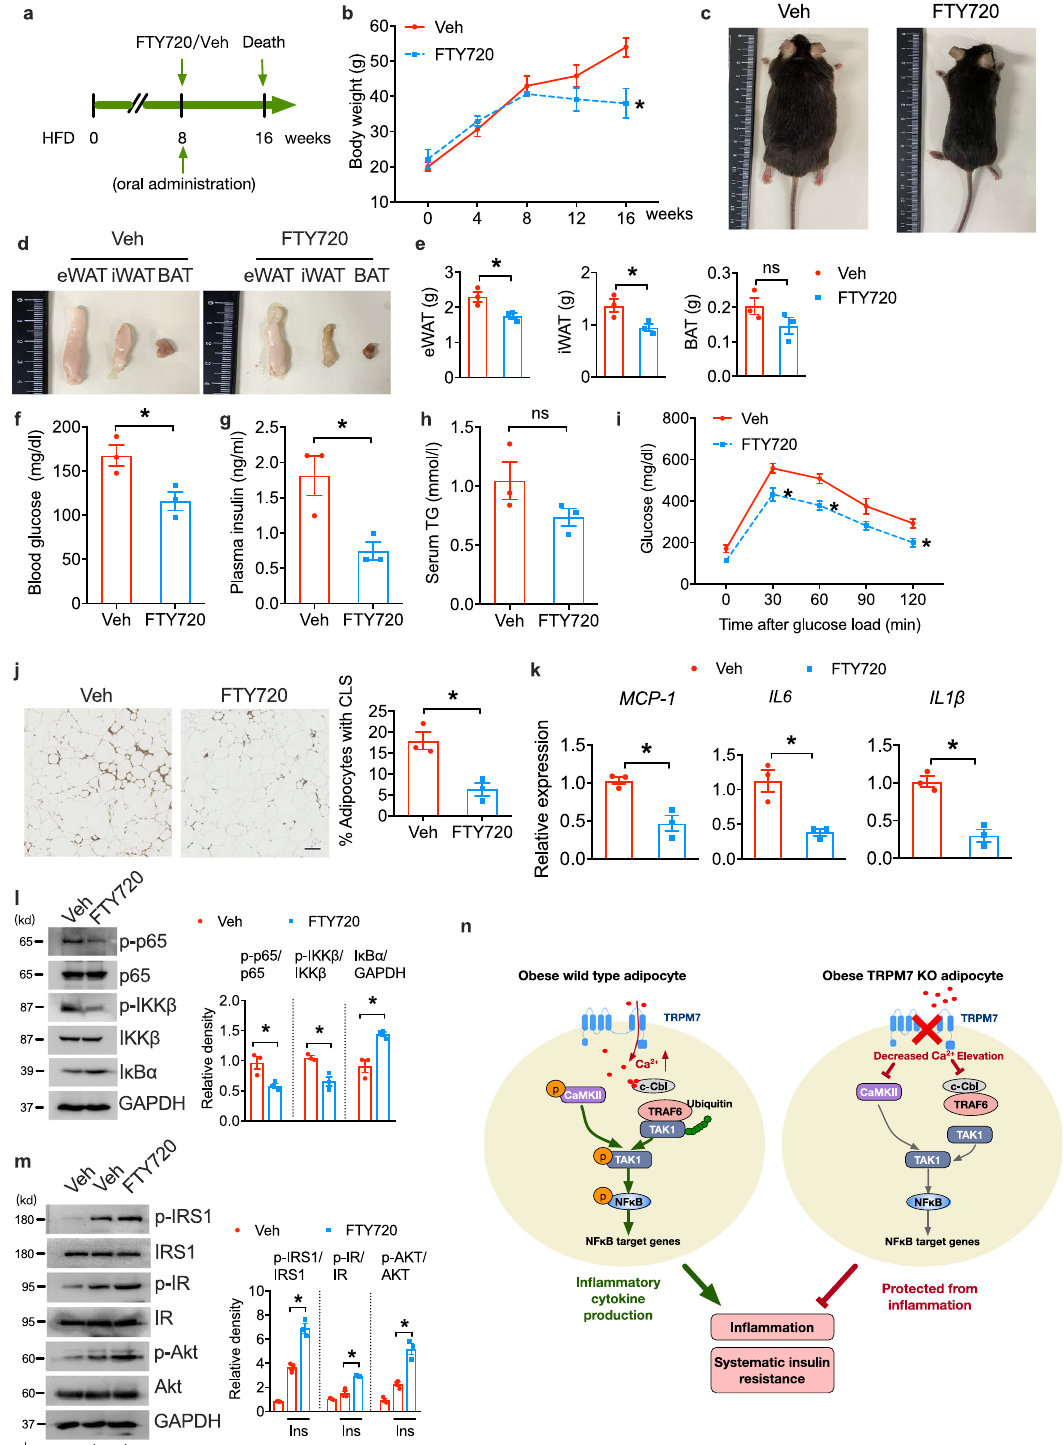
Fig. 8 | Effects of oral FTY720 on obese mice. a Schematic representation of experimentalschemefor FTY720oral administration. b Bodyweight onHFD ( n =3 mice). c Representative photographs of vehicle and FTY720-treated mice fed with CD or HFD ( n =3 mice). d , e Representative images ( d ) and fat mass weight ( e ) of eWAT, iWAT and BAT ( n =3 mice). f – h Serum glucose ( f ), insulin ( g ) and trigly- cerides ( h ) levels in overnight-fasted mice fed with HFD ( n =3 mice). i Glucose tolerance test in FTY720-treated and veh-treated mice fed with HFD ( n =3 mice). j Representativeparaf fi nsectionsofeWATstainedforF4/80.Barindicates100 μ m. Bar chart showing density of CLS ( n =3 mice). k Pro-in fl ammatory gene (mRNA)